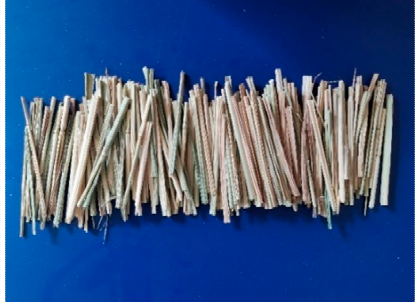
Figure 7. Straws for experiment.